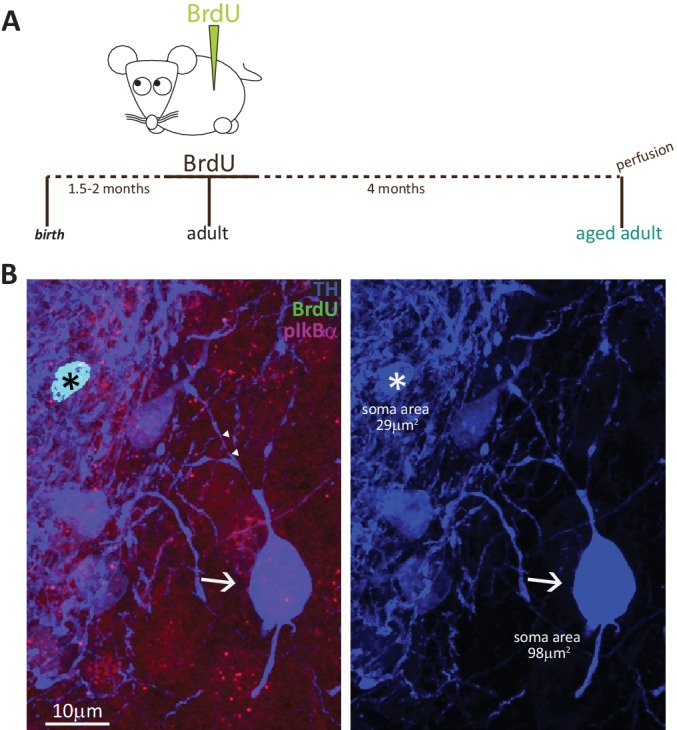
Fully mature adult-born DA neurons are small and never possess an AIS.(A) Schematic representation of the experimental strategy: pregnant wild-type mice were injected with a single dose of BrdU, and their tissue was collected 4 months later to allow full maturation of adult-born neurons. (B) Example image of adult tissue perfused 4 months post-BrdU injection, stained with antibodies against BrdU (green), TH (blue) and the AIS marker pIκBα (magenta). Asterisk indicates a BrdU +DA cell (TH+/pIκBα-), triangles indicate AIS start and end positions; the arrow indicates a neighbouring large AIS +DA neuron that is BrdU-negative.